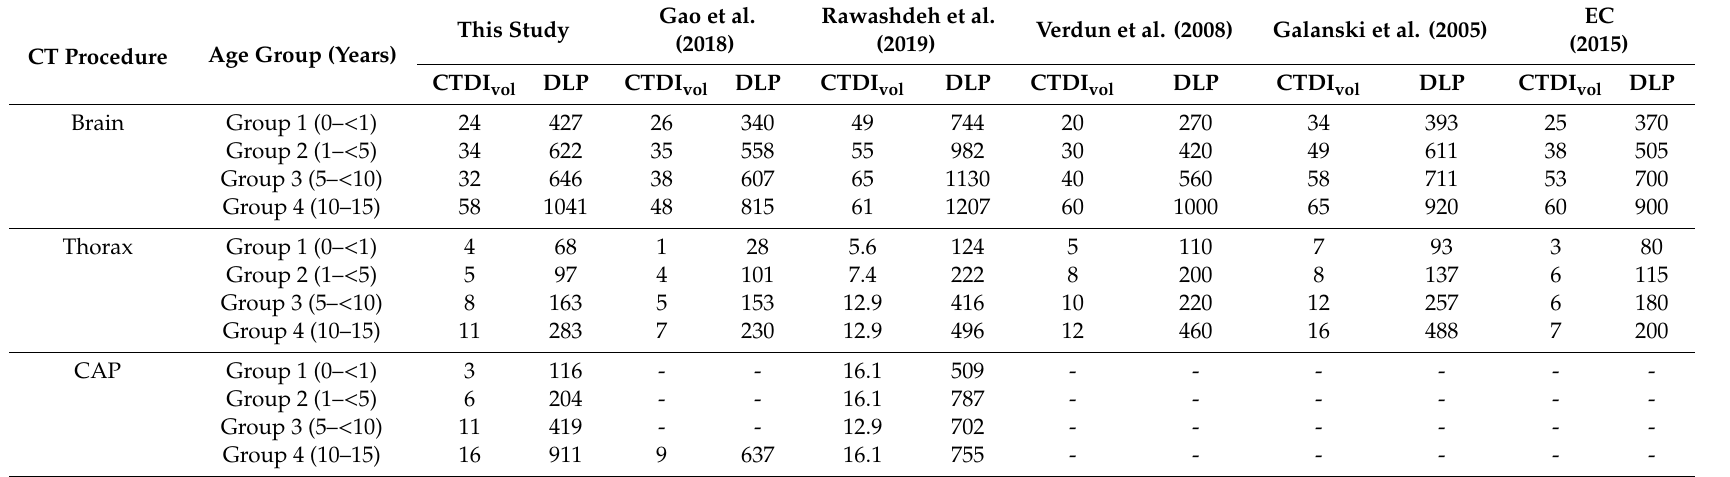
Table 5. Comparison of the third quartile (75th percentile) value with established diagnostic reference level (DRL) from other